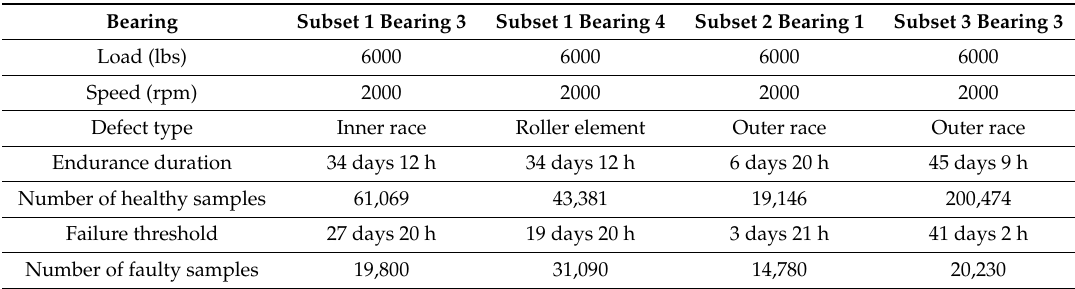
Table 1. Description of IMS bearing dataset [45]. The failure thresholds and the healthy and faulty samples were identified by the adaptive failure threshold.